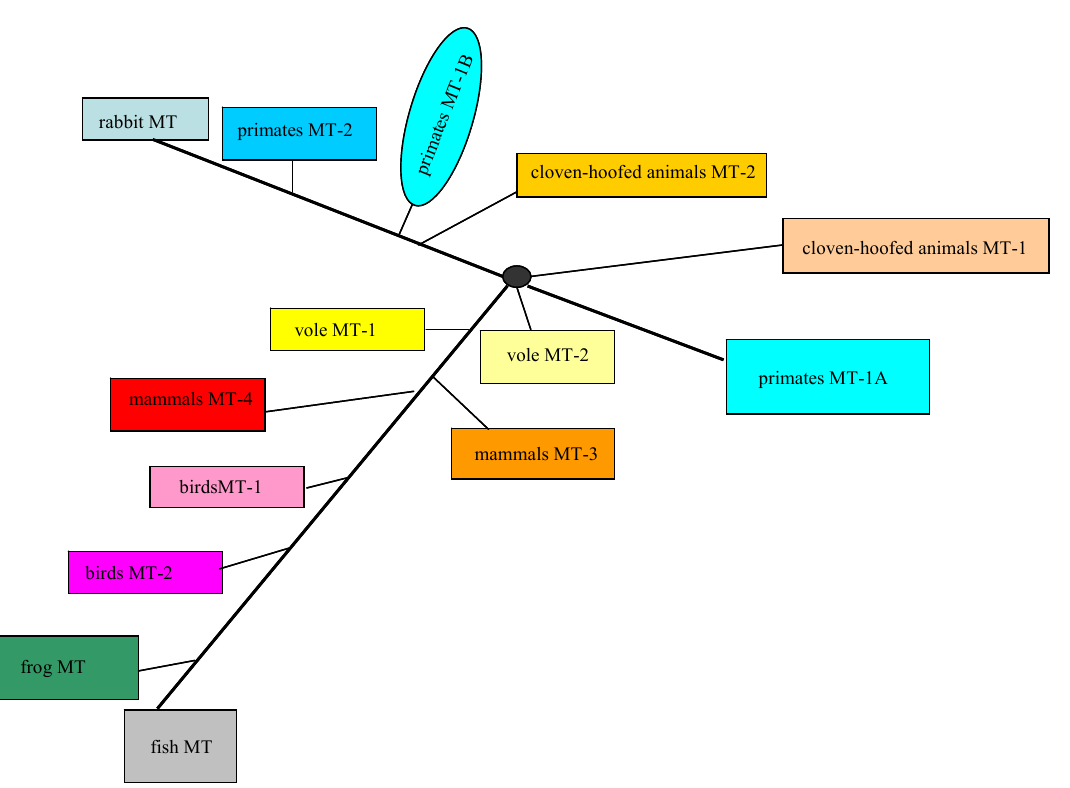
Figure 1. Phylogenetic tree of metallothioneins in vertebrates. Based on the data from